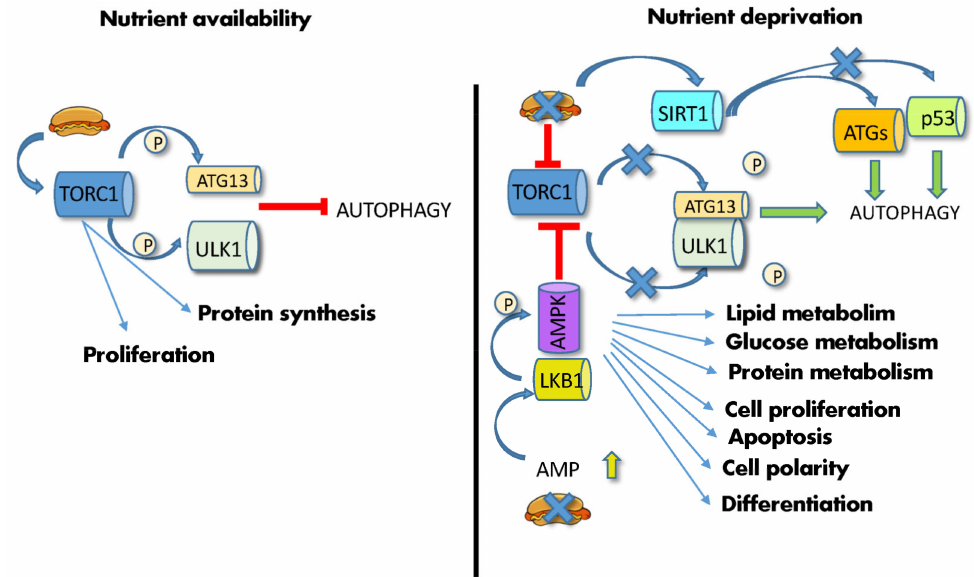
Figure 2. Effects of diet on autophagy. ( Left ) high nutrient availability activates mTORC1, which phos- phorylates ATG13 and ULK1, thus inhibiting autophagy. ( Right ) nutrient deprivation and low energy supply leads to increase in AMP and AMPK phosphorylation by LKB1, leading to mTOR inhibition, ATG13/ULK1 dephosphorylation/activation and initiation of autophagy. Low ATP levels also activate SIRT1, which induces the deacetylation of the autophagic ATG proteins, and p53. Abbreviations: AMP: adenosine monophosphate; AMPK: 5 (cid:48) AMP-activated protein kinase; ATG13: autophagy-related gene; LKB1: liver kinase B1; P: phosphate; p53: tumor protein P53; SIRT1: silent information regulator 1; TORC1: mechanistic target of rapamycin complex; ULK1: Unc-51-like autophagy activating kinase